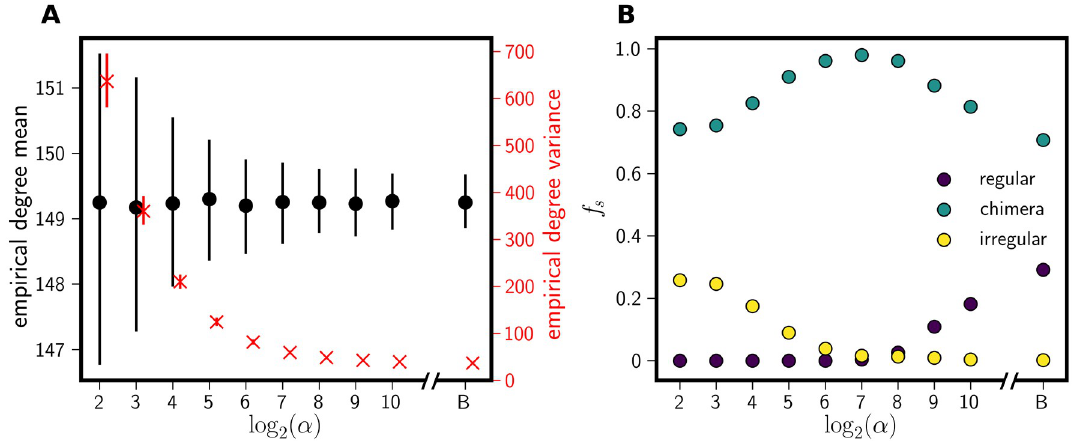
Fig 5. Effect of degree heterogeneity on state frequencies. Panel A shows the degree statistics (mean and variance) for 1000 beta networks of size N = 200 for each α value shown. The mean connectivities were fixed at a value corresponding to p = 0.75 in the binomial random graph model. The axis label ‘B’ indicates a binomial random graph with N = 200 and p = 0.75; otherwise, the tick label indicates the value of α . The empirical mean degree is plotted in black (left axis) and the empirical degree variance in red (right axis). In each case, points mark the median ensemble value, and the vertical bars range from the first to third quartiles. The empirical degree variance was shifted slightly to the right to minimize overlap of the data. Panel B shows the frequency of each network state generated from the 1,000 beta networks for each α value, starting with random initial conditions. As α increases, the empirical degree variance decreases resulting in fewer temporally-irregular and more temporally-regular network